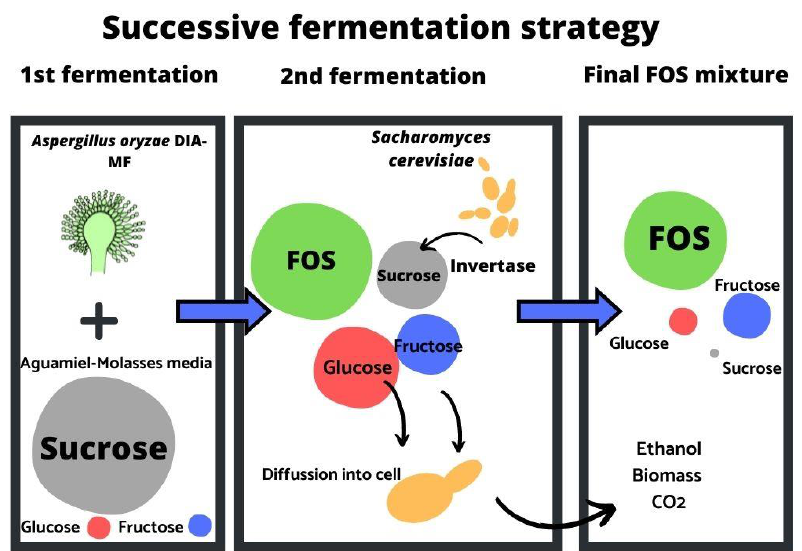
Figure 6. Schematic representation of successive fermentation. First fermentation: fructooligosac- charides (FOS) synthesis by Aspergillus oryzae DIA-MF in Aguamiel-Molasses (AgMe) media. Sec- ond fermentation: Saccharomyces cerevisiae acts on the FOS mixture reducing the content of mono- and disaccharides. A higher FOS% was obtained in the fermentation mixtures treated with the succes- sive fermentation with strains S227 and S200. However, the strain S227 showed more ef- ficiency, reaching 61.04 ± 0.64% of FOS in 16 h of fermentation in comparison with S200, which reached the highest FOS% (62.12 ± 2.57) after 40 h of fermentation time.